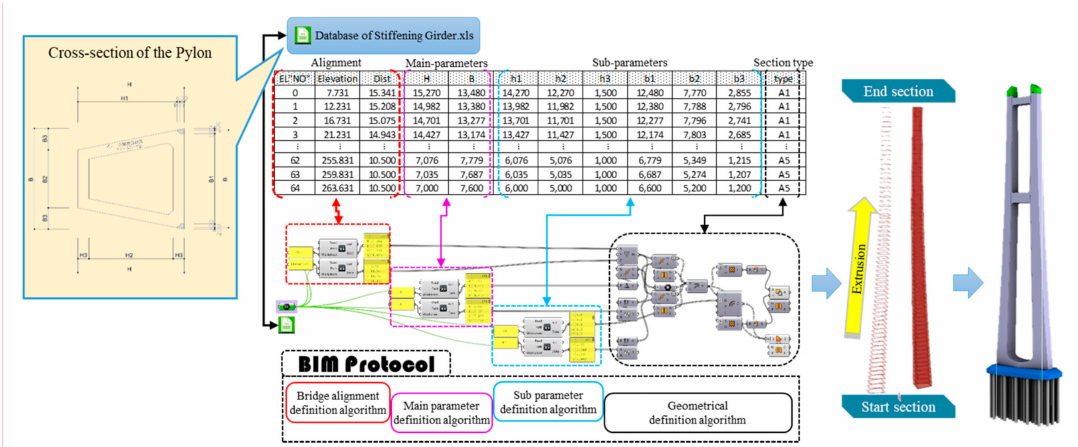
Figure 7. The geometrical algorithm in the BIM protocol for 3D modeling